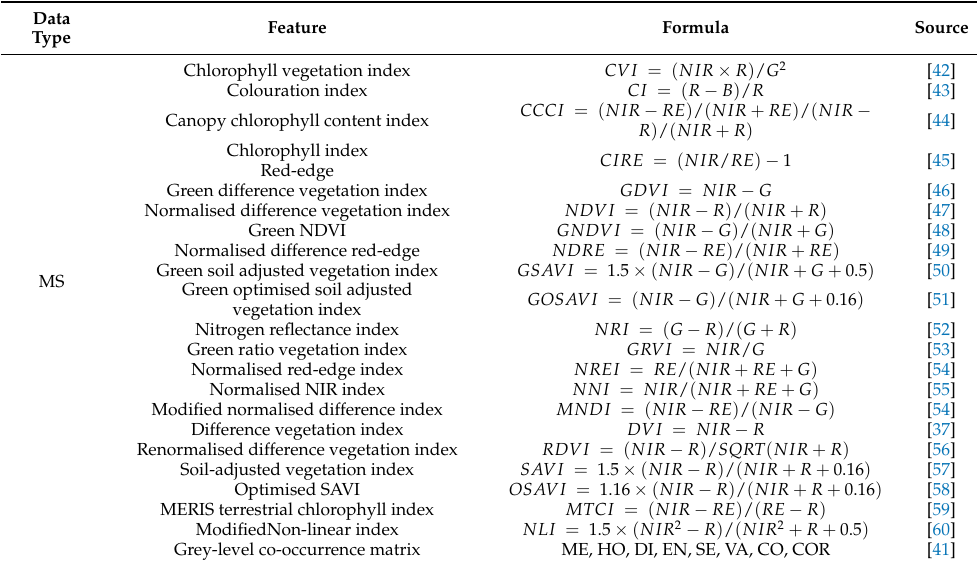
Table 3. Spectral and textural features of multispectral